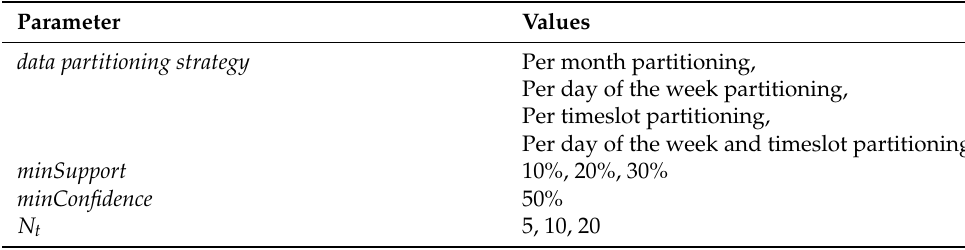
Table 8. Parameters